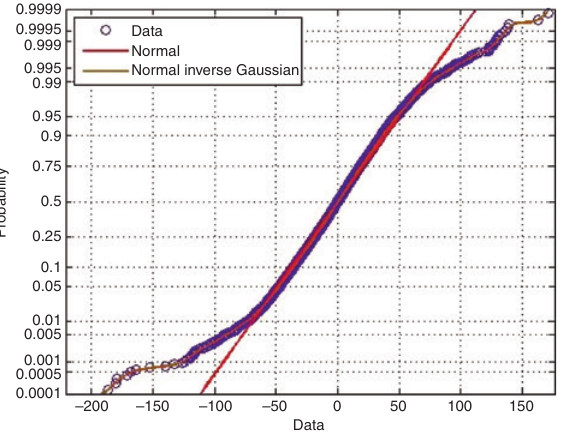
Figure 3: Probability Plot for MRI Data.